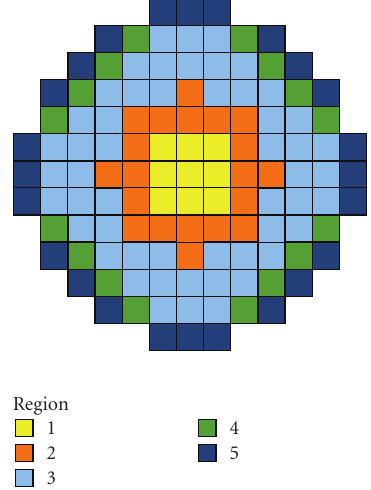
Figure 2: Radial cross-section of the NEK